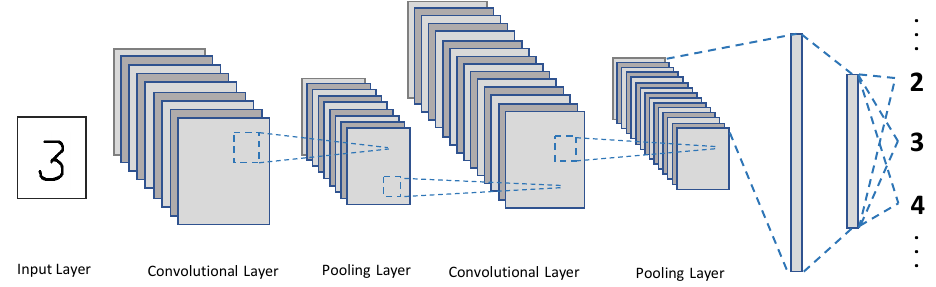
Figure 2. CNN Architecture for Image Classification. A CNN typically consists of convolutional and pooling layers followed by one or more fully connected layer. The softmax function is applied in the last fully connected layer to compute the probabilities of the object in the input image belongs to the predefined classes. Finally, the input image is classified as the category with the highest